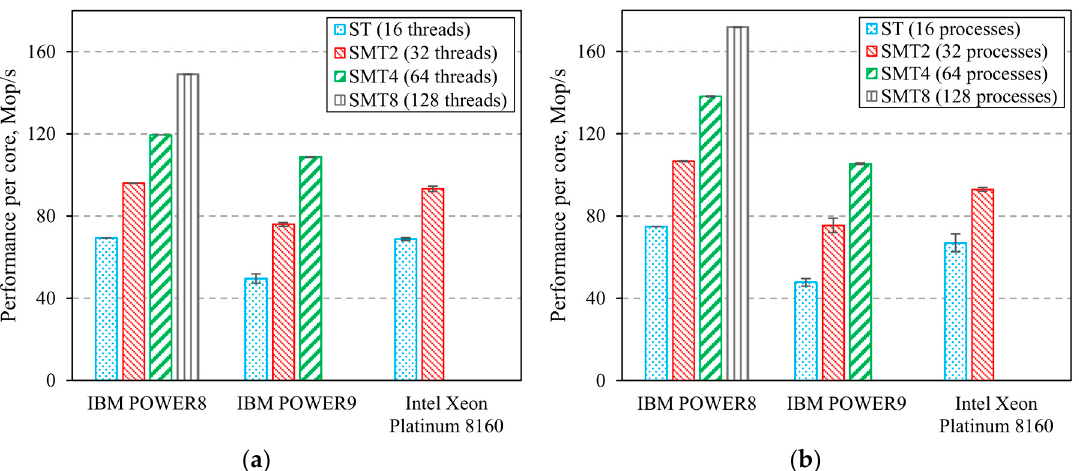
Figure 3. EP benchmark results: OpenMP version ( a ) and MPI version ( b ).